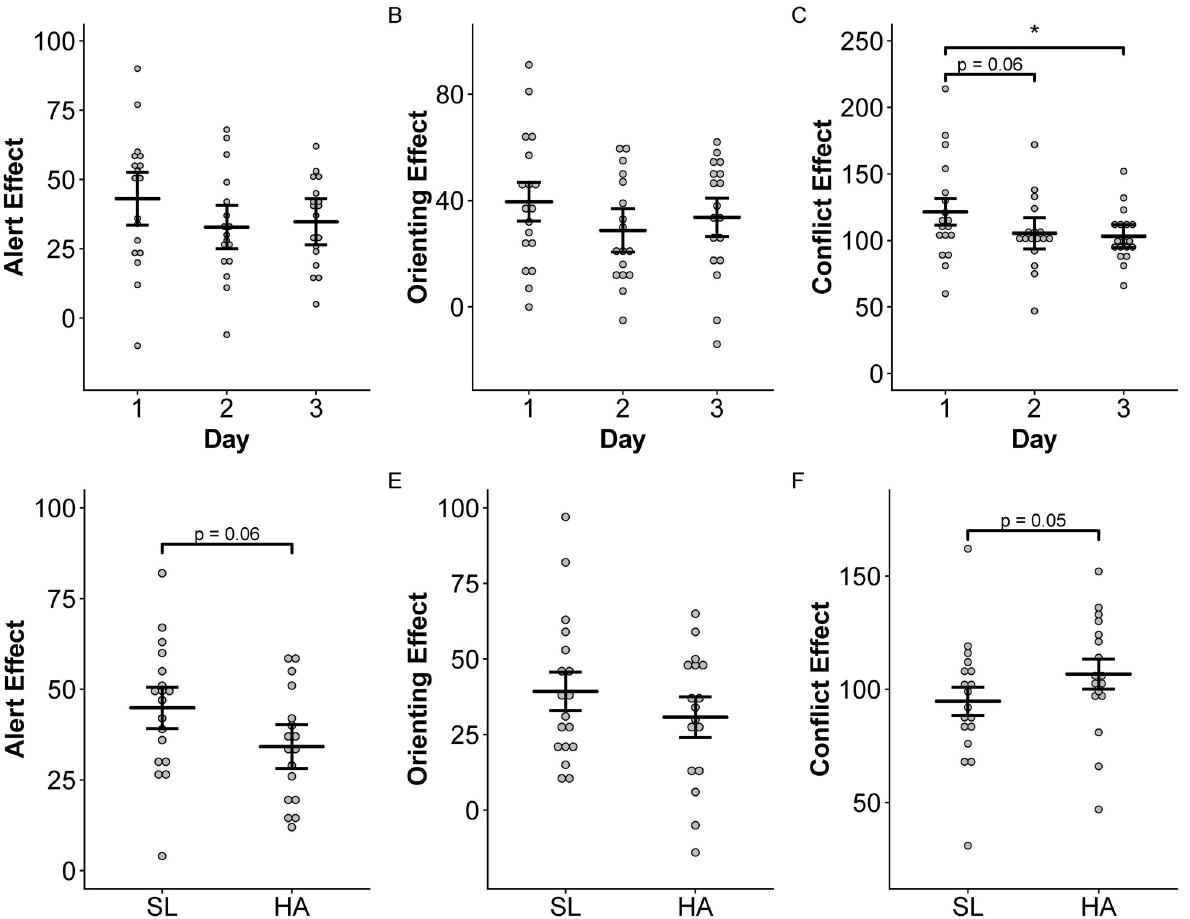
Fig 6. Effects of altitude on ANT performance. Alert, Orienting, and Conflict Effect scores on the ANT over three consecutive days at high altitude (top panels) and at sea level (SL) compared to the no-treatment night at high altitude (HA, bottom panels). Means and 95% confidence intervals are presented for each group. Asterisks indicate significant differences across days or locations at p < 0.05 ( � ).